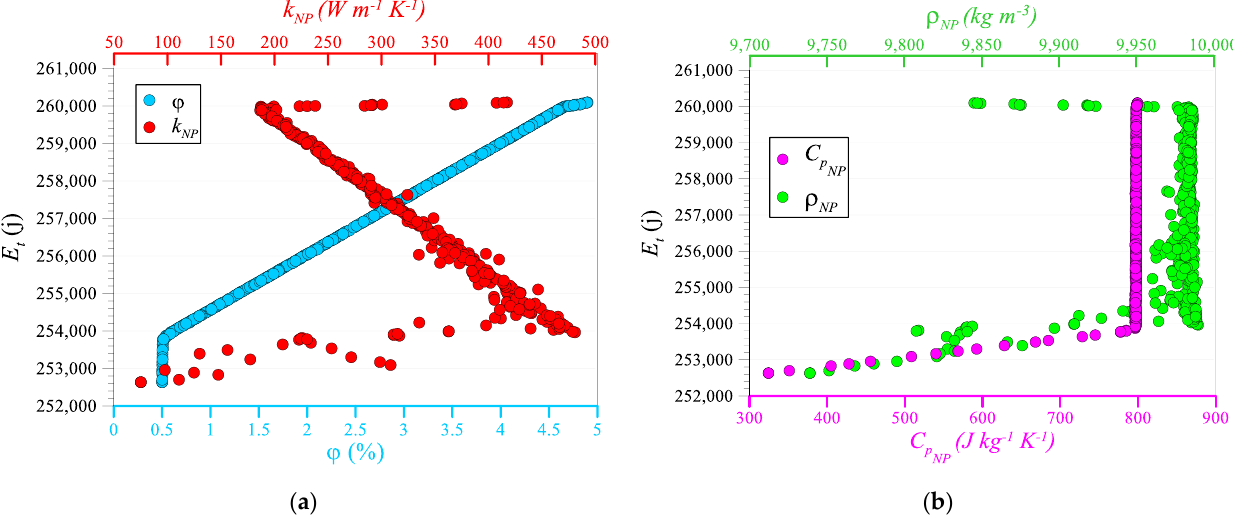
Figure 11. Optimal variation of total stored energy ( 𝐸 𝑡 ) with respect to ( a ) volume fraction and thermal conductivity, ( b ) specific heat and density.